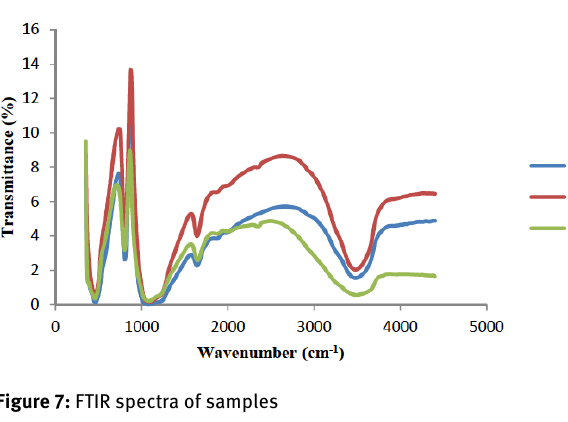
Figure 7: FTIR spectra of